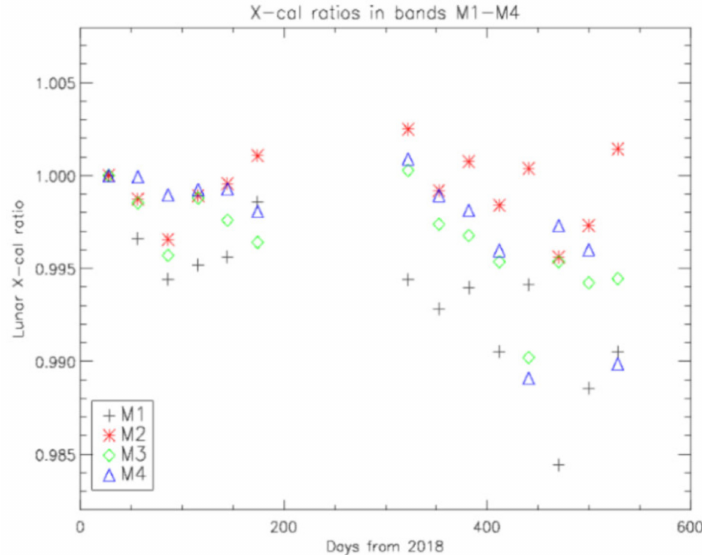
Figure 8. Cross-calibration ratios of NOAA-20 VIIRS in the short wavelength bands (M1~M4) using SNPP-VIIRS with matching scheduled lunar